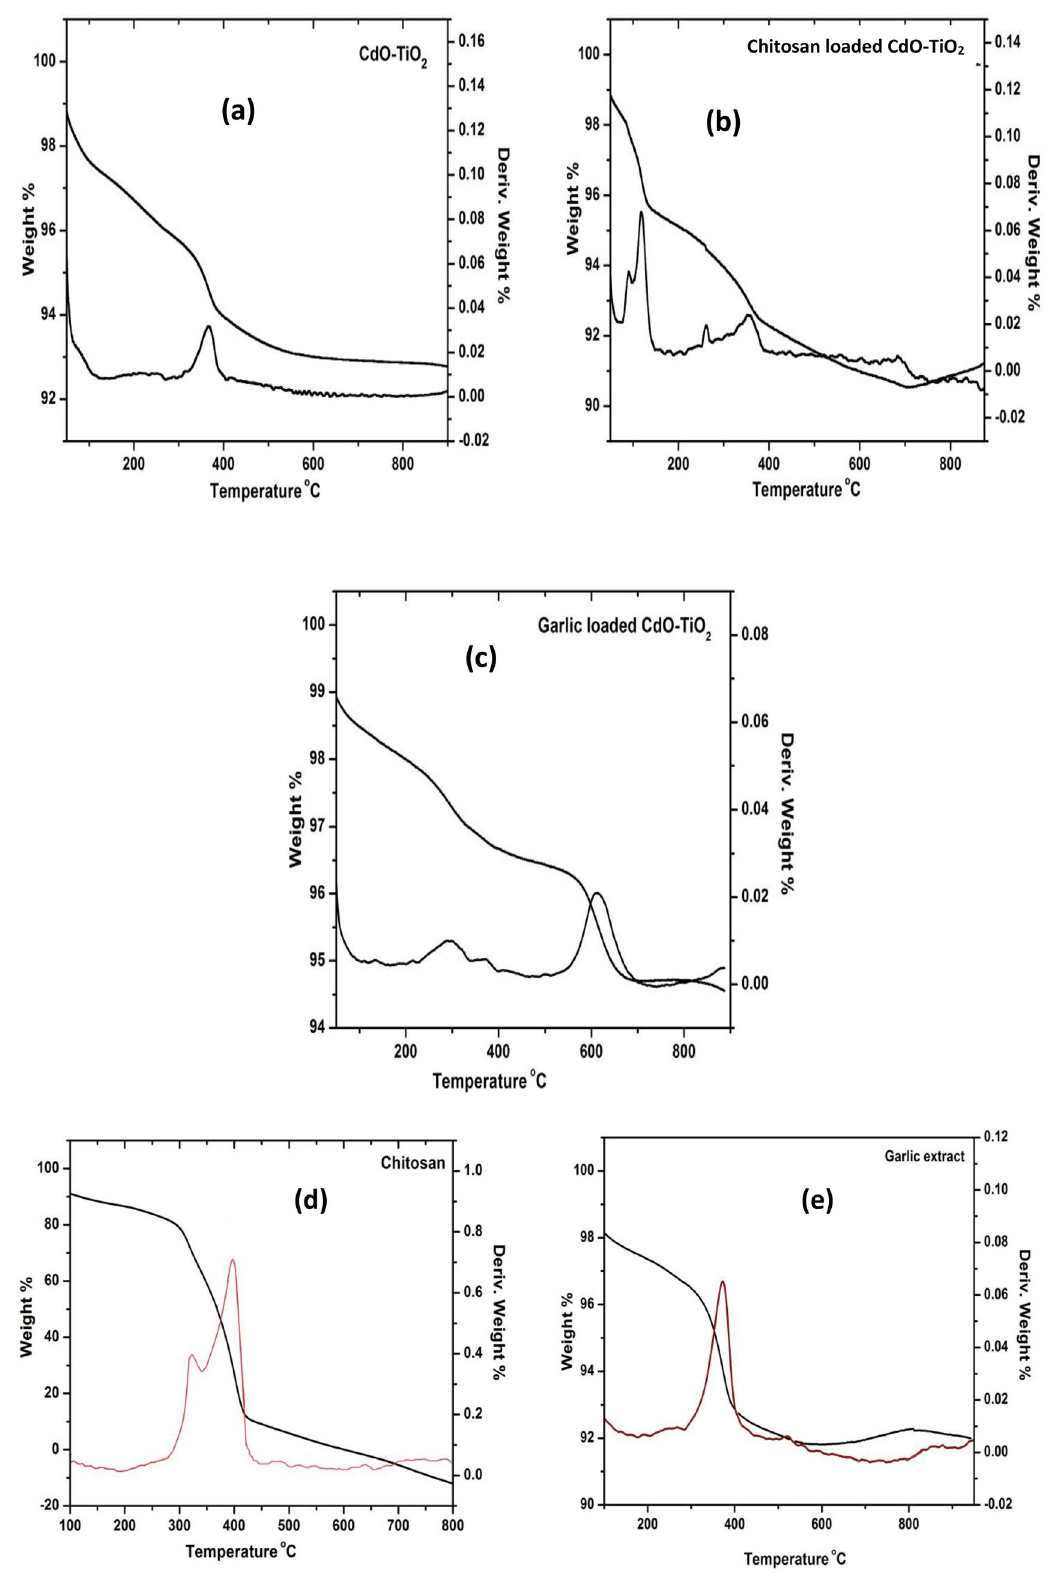
Figure 8. TG–DTA of ( a ) CT ( b ) CS-CT ( c ) AS-CT nanocomposites ( d ) Chitosan and ( e )